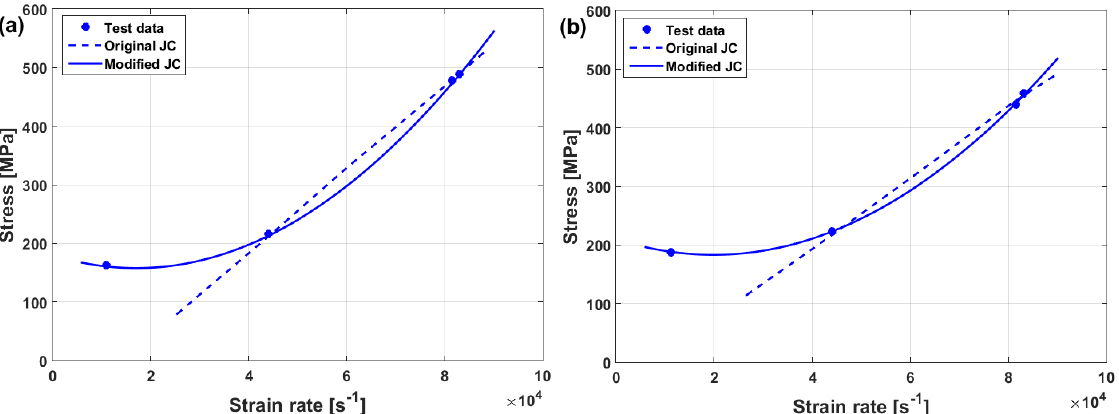
Figure 11. Initial yield stress vs. strain rate using both the original JC model and the modified JC model that was presented by Kang et al. [69] for ( a ) SPCC and ( b ) SPRC.